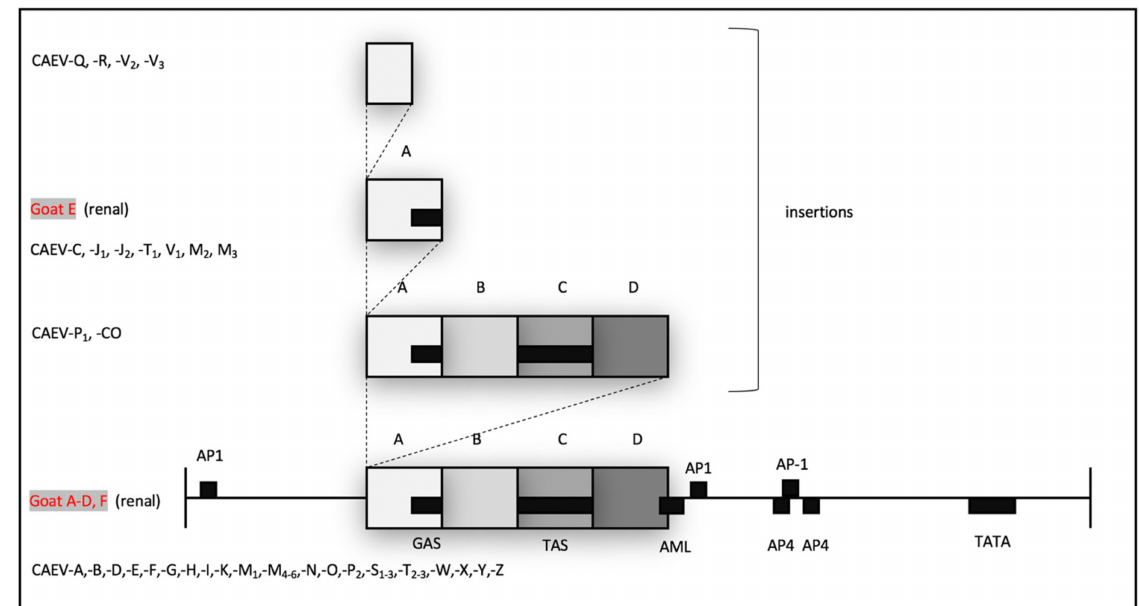
Figure 7. Schematic map of the CAEV U3 region (promoter). Promoter motifs are represented as black boxes and are named. The 70 base pair repeat (contiguous grey boxes) is broken into 4 subregions, A, B, C and D. Promoter isolates with sequence insertions are demonstrated schematically above the promoter map. CAEV sequences derived from renal isolates are in red (goats A–F); previously published sequences are in black (CAEV-A through CAEV-Z). Figure adapted with permission from BG Murphy, VM Elliott, N CVapniarsky, A. Oliver and J. Rowe (2010)